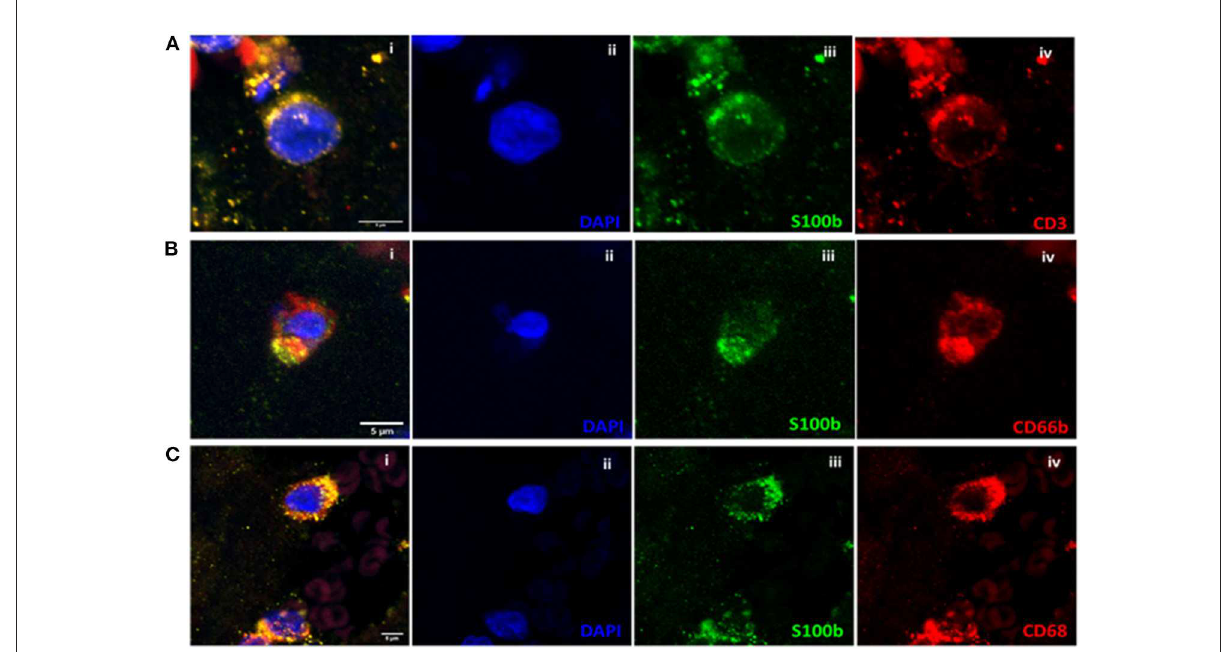
FIGURE4 (A) Co-localization analysis of S100b and CD3 in clot with the three channels together (i) and separately (ii–iv). (B) Co-localization analysis of S100b and CD66b in clot with the three channels together (i) and separately (ii–iv). (C) Co-localization analysis of S100b and CD68 in clot with the three channels together (i) and separately (ii–iv). All images were captured using the 60 × objective (scale bar 5 µ